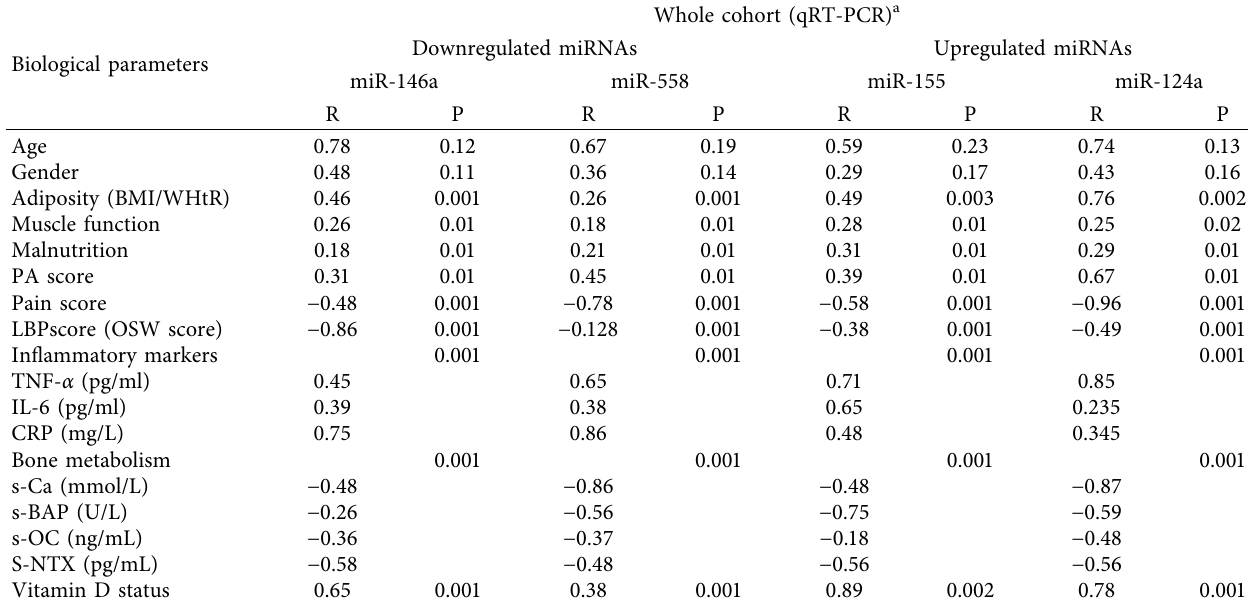
Table 2: Correlation between circulating miRNAs concentrations and biological parameters in patients with low back pain (LBP) ( n � 110). Biological parameters